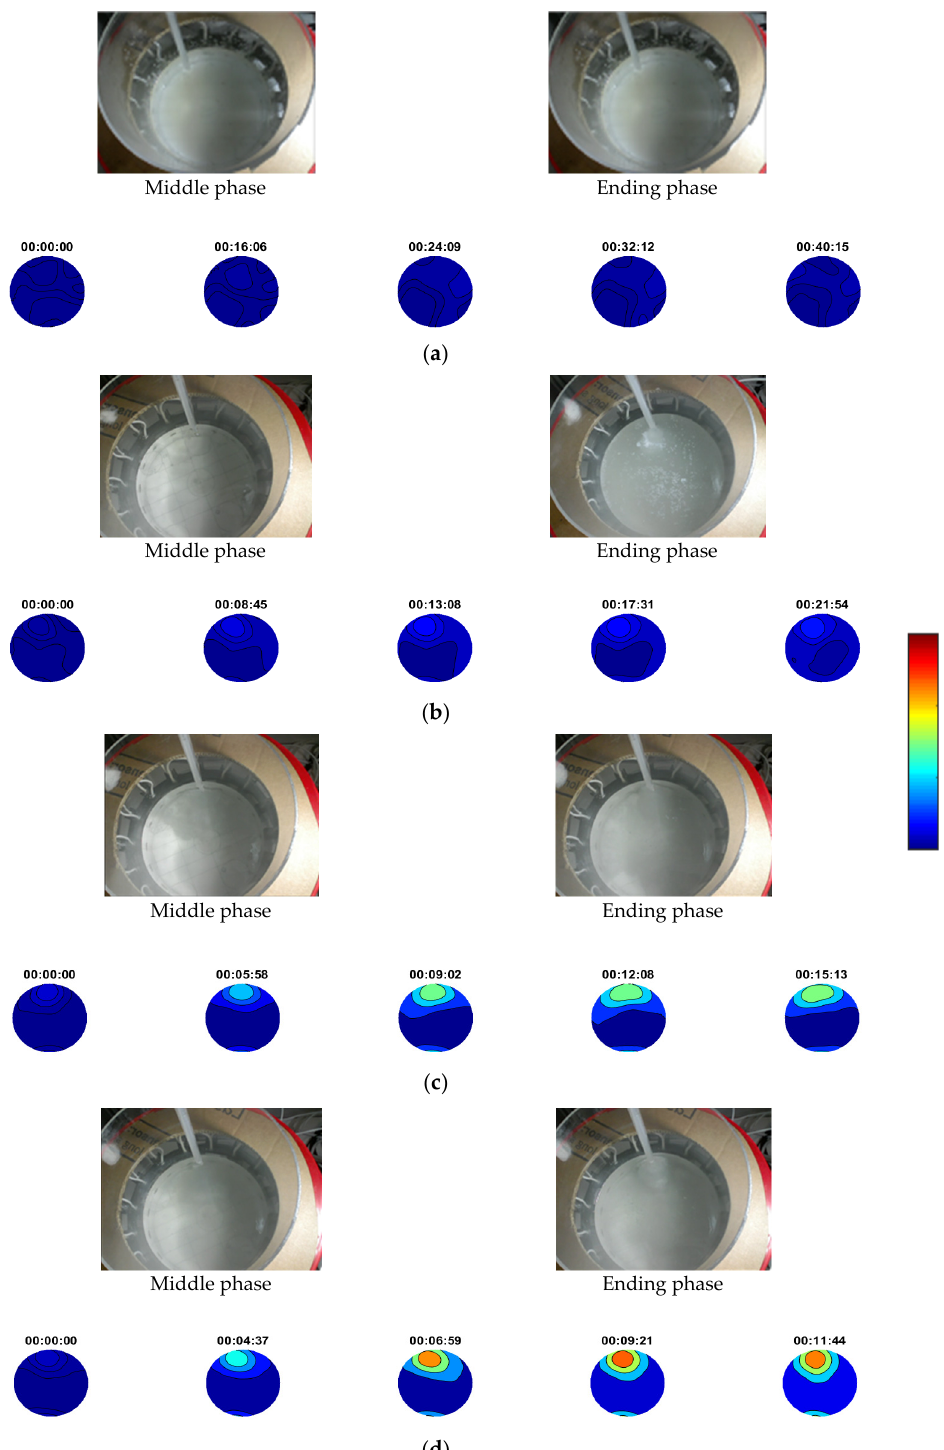
Figure 10. Reconstructions of non-stirring calcium carbonate crystallisation experiments. ( a ) 9 mL/min, ( b ) 18 mL/min, ( c ) 27 mL/min and ( d ) 36 mL/min injection rate. Note that a uniform image scale bar is used for all four sets of experiments to provide comparative evaluation. Scale bar describes pulses’ travel-time delays.